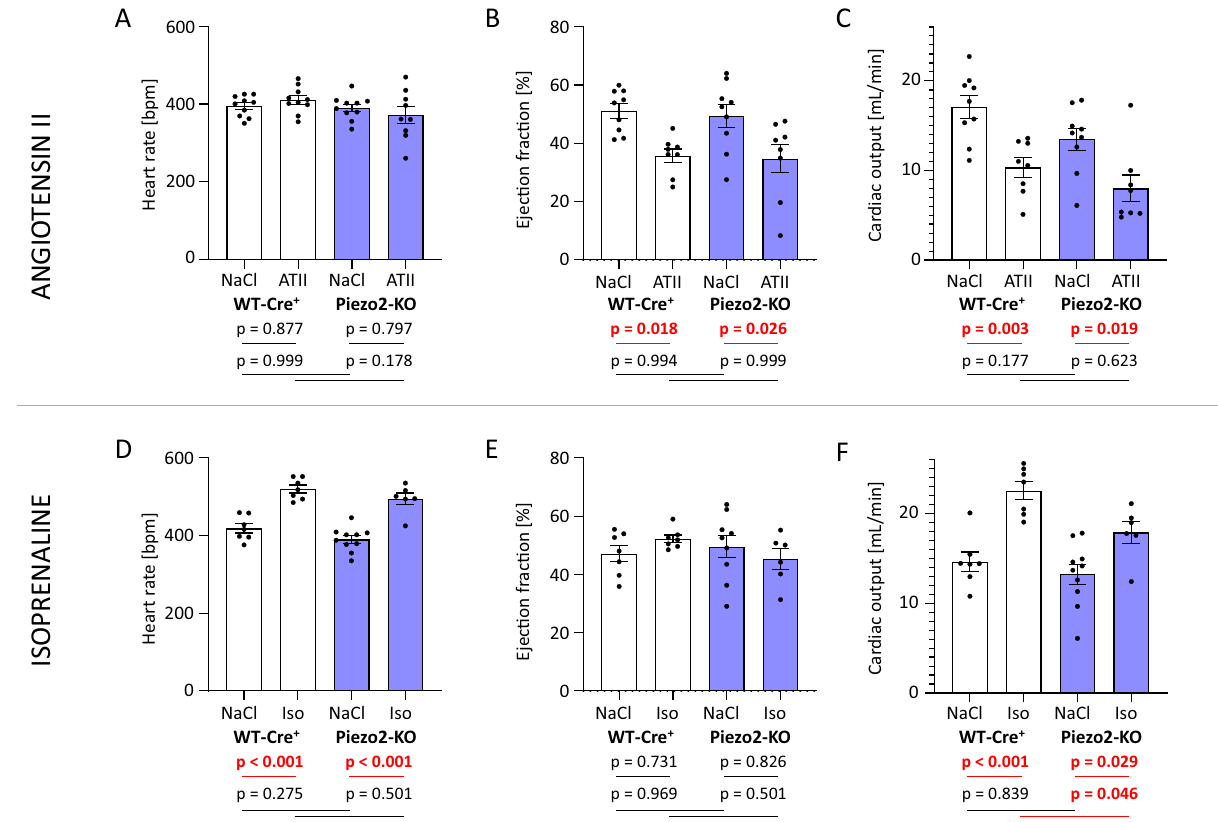
Figure 5. Heart function of WT-Cre + and Piezo2-KO mice after angiotensin II or isoprenaline treatment. ( A ) Heart rate was assessed by electrocardiography, ( B ) ejection fraction and ( C ) cardiac output by echocardiography, all after three weeks of angiotensin II (ATII) treatment. Accordingly, ( D ) heart rate, ( E ) ejection fraction and ( F ) cardiac output were assessed after one week of isoprenaline